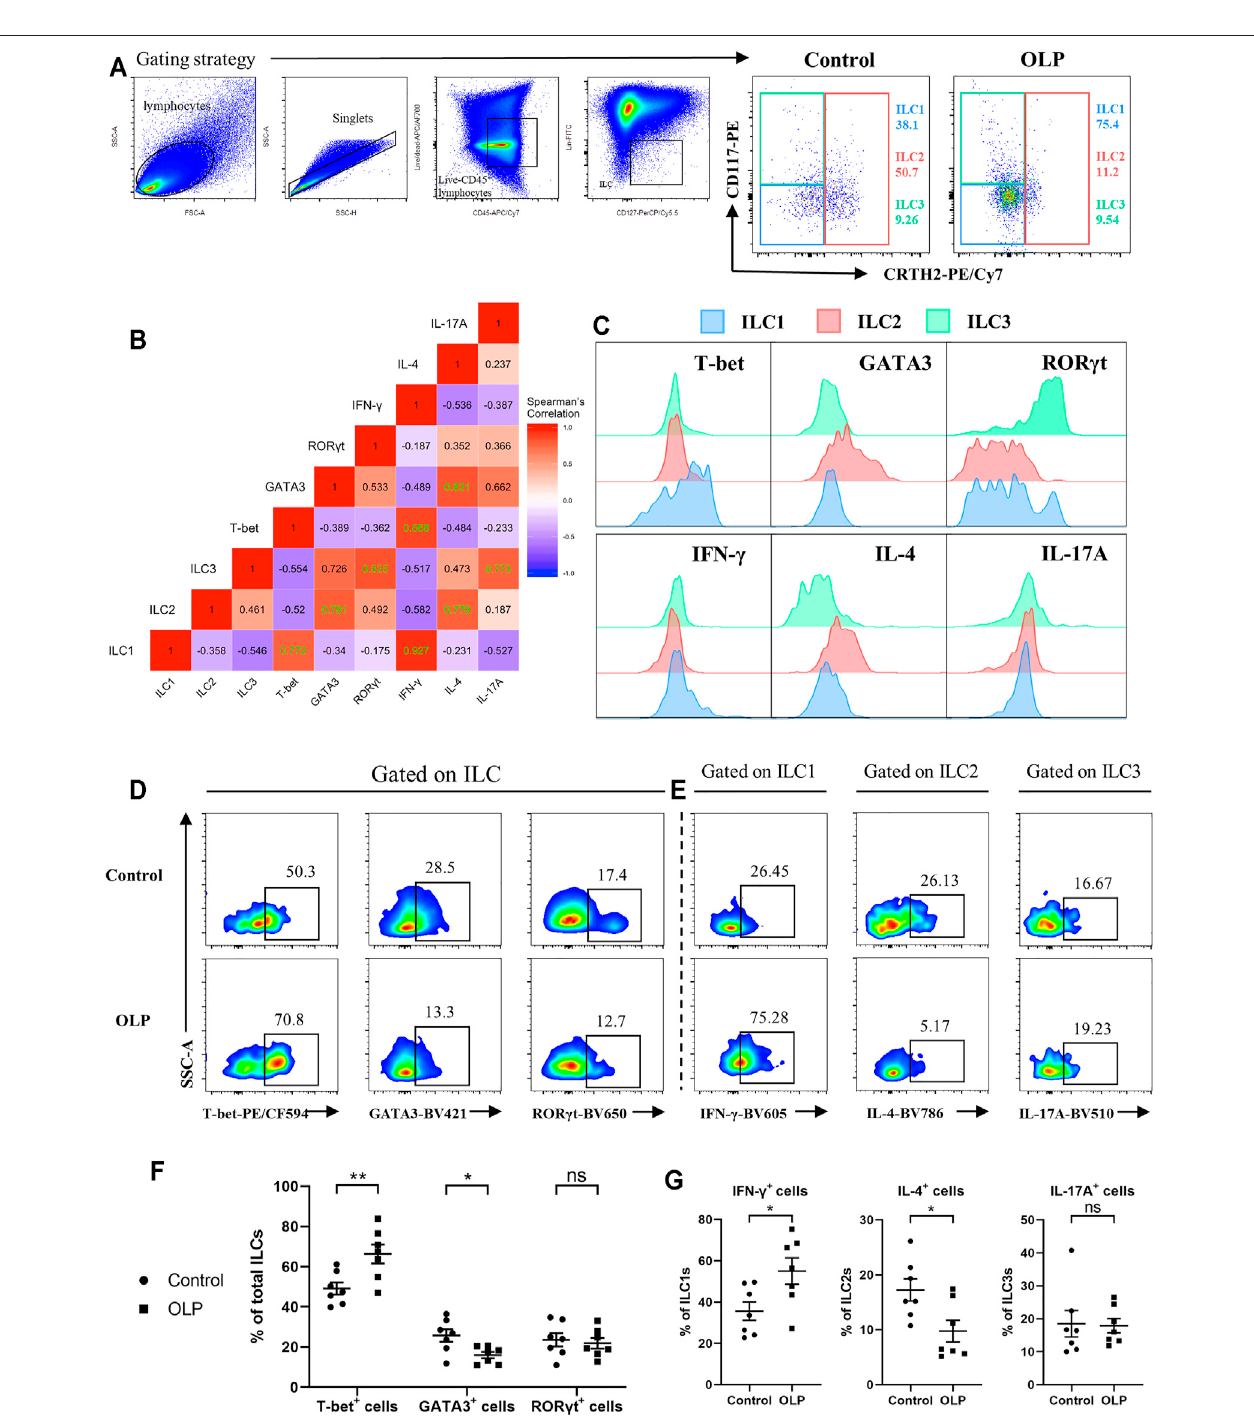
FIGURE 4 | Transcriptional and cytokine expression pro fi les of ILCs. PBMCs collected from OLP patients and healthy controls were stimulated with PMA/ ionomycin/Brefeldin A for 6 h and then subjected to intracellular staining and fl ow cytometric analyses. (A) Gating strategy to de fi ne ILC1/2/3. (B) Correlation heatmap depicting expression of transcription factors/cytokines in ILCs (Spearman ’ s correlation coef fi cient, healthy controls). Statistically signi fi cant correlations (two-tailed p < 0.05) are denoted in green. (C) Representative histograms of healthy individuals depicting transcriptional and cytokine expression pro fi les of ILC1/2/3. RepresentativeFACSplotsofexpressionofT-bet,GATA3,andROR γ tintotalILCs (D) aswellasexpressionofIFN- γ inILC1s,expressionofIL-4inILC2,andexpression ofIL-17AinILC3 (E) amongcontrolandOLPgroups. (F) PercentagesofT-bet + ,GATA3 + ,andROR γ t + cellsinILCs. (G) PercentagesofIFN- γ + cellsinILC1s,IL-4 + cellsin ILC2s, and IL-17A + cells in ILC3s. Data are depicted as a bar graph with mean ± SEM. Two-tailed unpaired Mann – Whitney tests were performed, * p < 0.05, ** p < 0.01. ILCs, innatelymphoidcells;PBMCs,peripheralbloodmononuclearcells;OLP,orallichenplanus;PMA,phorbol12-myristate13-acetate;FACS, fl uorescence-activated cell